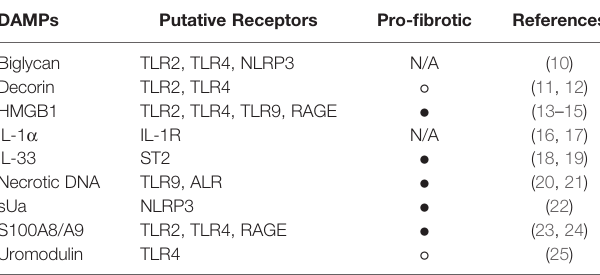
TABLE 1 | List of known DAMPs in